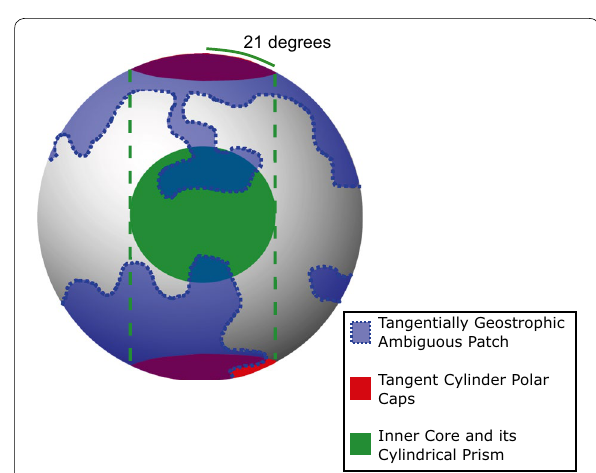
Fig. 2 Location of the tangent cylinder and tangentially geostrophic ambiguous patches. The tangent cylinder can be described by two caps subtending an angle of 21 ◦ at the Earth’s center (red) projecting the inner core to the surface of the core–mantle boundary (green) along the rotation axis. A schematic illustration of the tangentially geostrophic ambiguous patches is also shown in